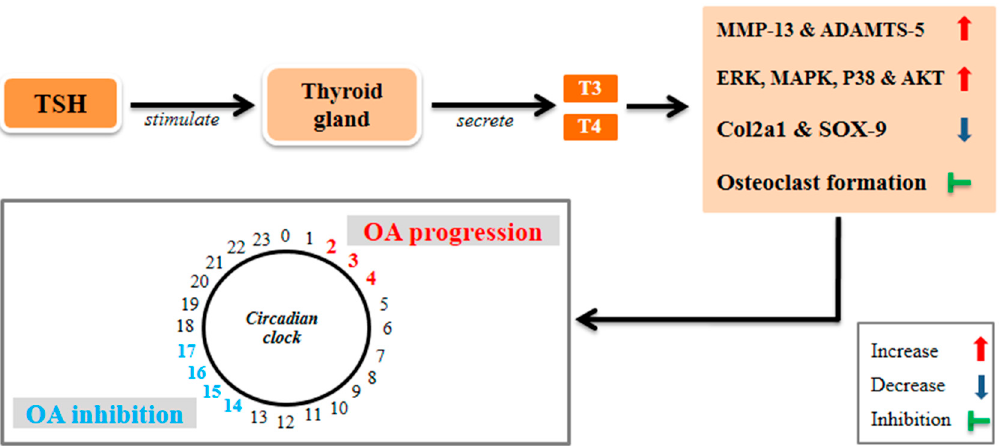
Figure 4. TSH stimulates the thyroid gland to secrete T3 and T4. TSH decreases Col2a1 and SOX-9 expression through activation of ERK, MAPK, and P38, as well as enhancing the expression of matrix metalloproteinase (MMP)-13 and a disintegrin and metalloproteinase with thrombospondin motif (ADAMTS)-5, which are responsible for cartilage degradation. The circadian clock-controlled TSH hormone shows peak levels shortly after midnight (02:00–04:00), which may promote OA. In contrast, lower levels, typically seen between 14:00 and 17:00, may inhibit OA progression.